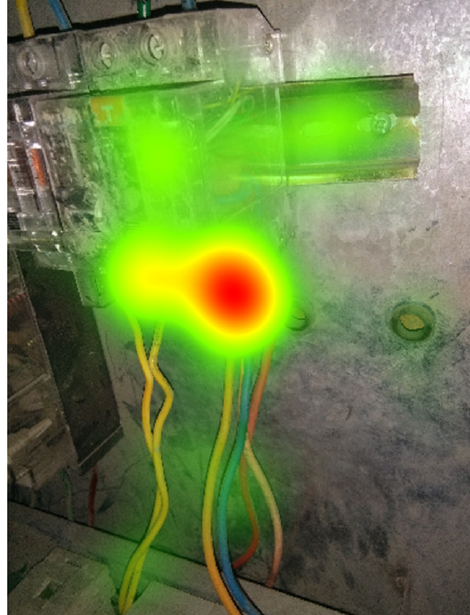
Figure 4. The visual heat map of Hazard #1.